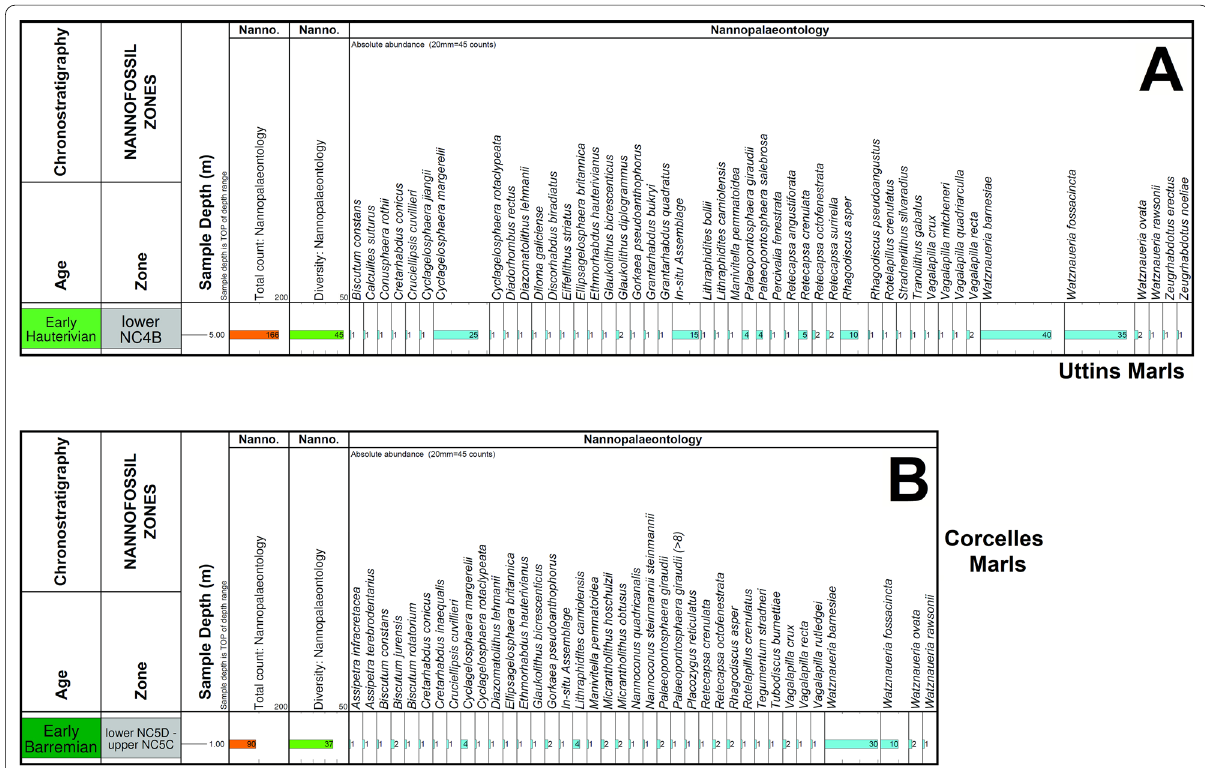
Fig. 12 Nannofloras from the late Early Hauterivian Uttins Marls ( A : sample from the Mont de Chamblon section, VD) and Early Barremian Corcelles Marls ( B : sample from the Corcelles‑2 section, NE). In order to avoid very high numbers for nannofossil counts, a 0–100 based counting system is used. The numbers for individual species represent semi‑quantitative count estimation of specimens/100 fields of view (FOV). Numbers from 1 to 20 represent the estimation of species per 100 FOV. Numbers above 20 are coded: 25 (one specimen/4FOV), 30 (one specimen/3FOV), 35 (one specimen/2FOV), 40 (one specimen/1FOV). The numbers for total abundance ( in situ ) estimation represent the number of specimens per 5 FOV. For the taxonomy (names by authors) and detailed biostratigraphy, see also Internet website https:// www. mikro tax.